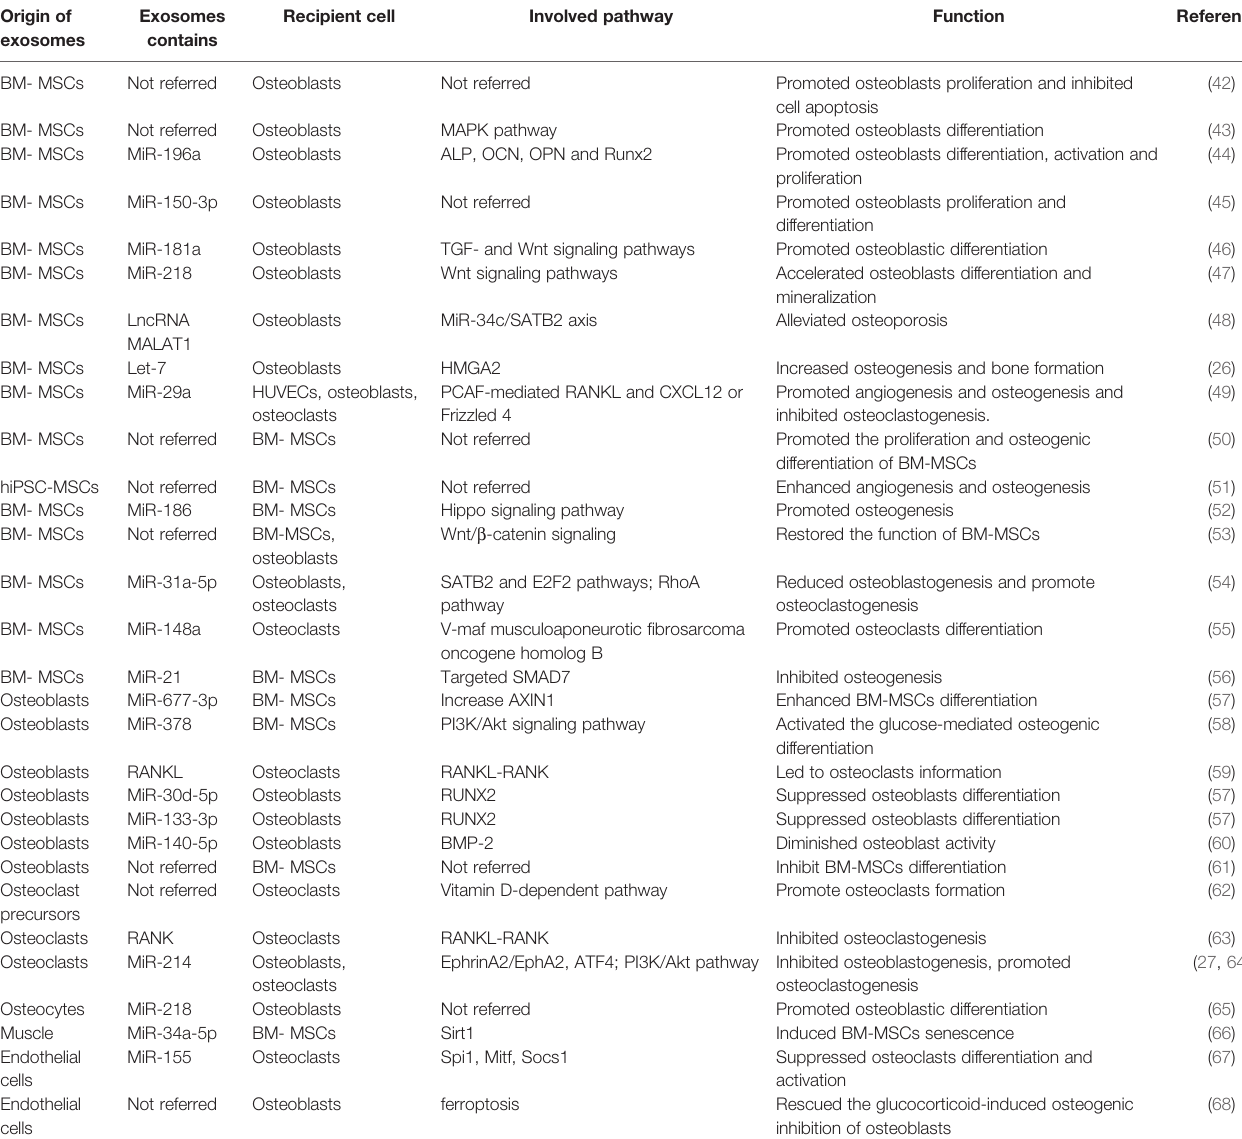
TABLE 2 | Bone-related cells derived exosomes in OP. Origin of Exosomes Recipient cell Involved pathway Function exosomes contains